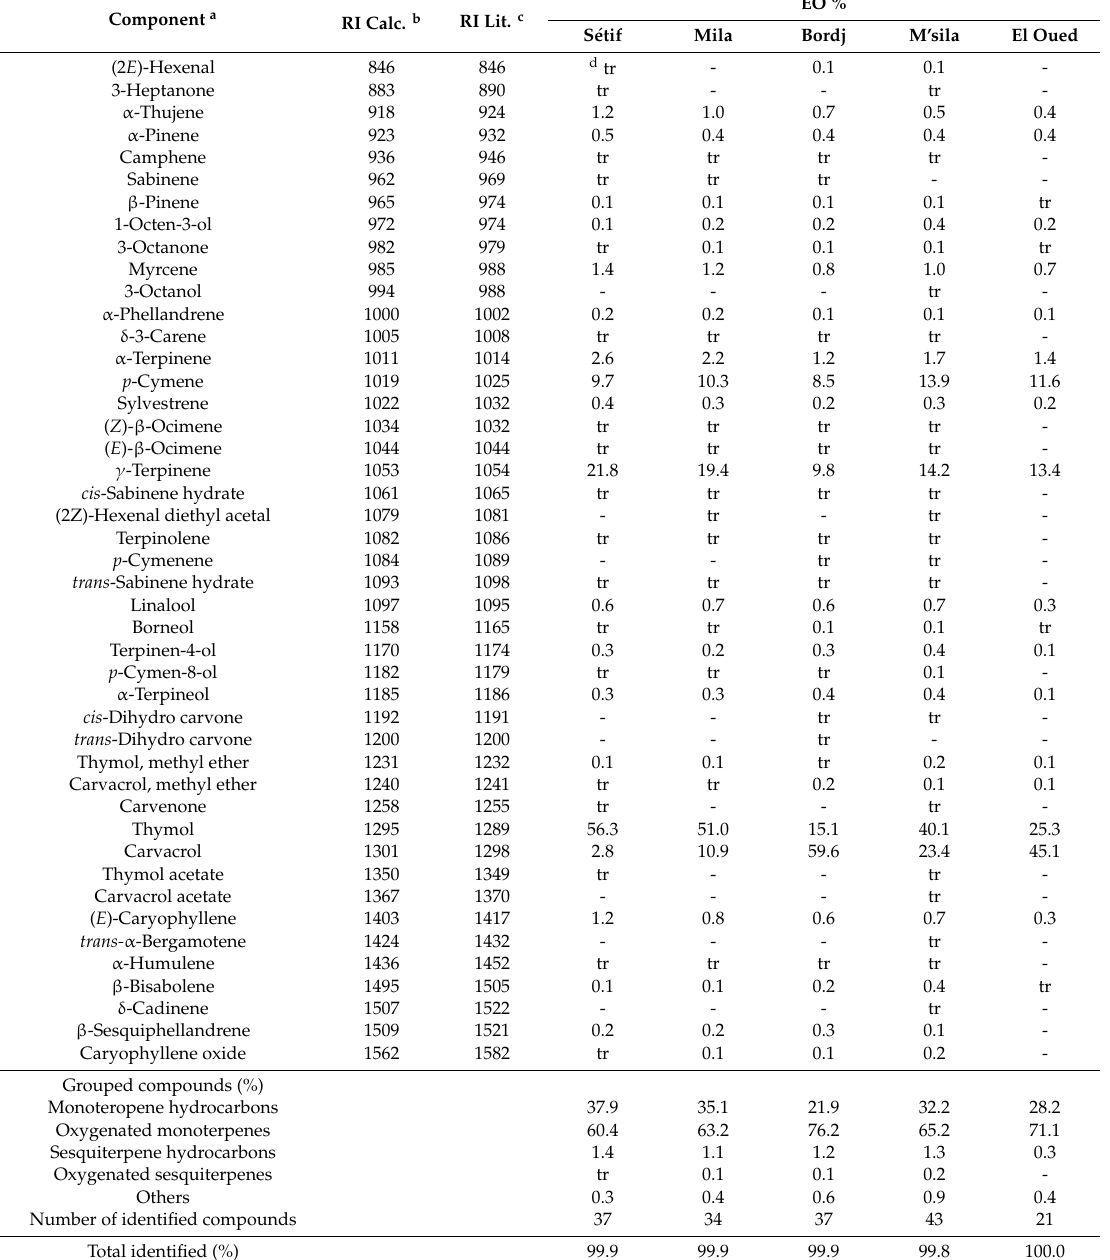
Table 1. Chemical composition of the EOs from five populations of the Algerian endemic O. glandulosum